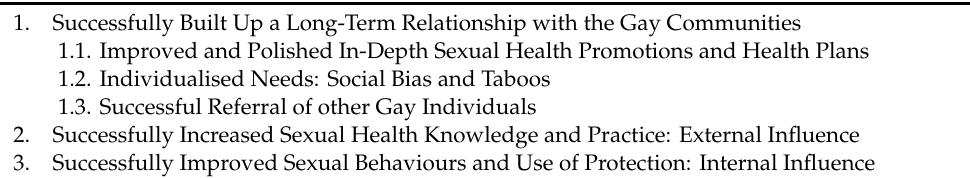
Table 1. Themes and